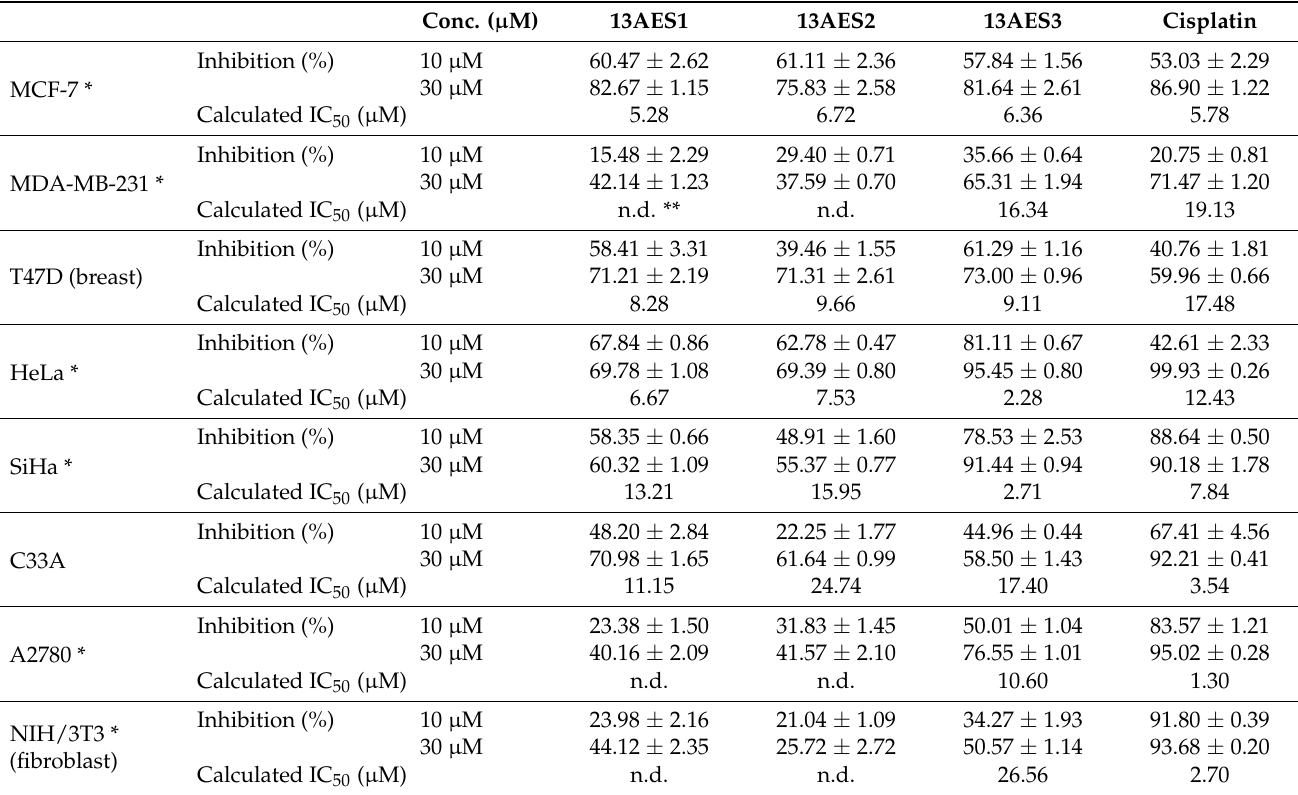
Table 1. Antiproliferative properties of 13AES1–3.